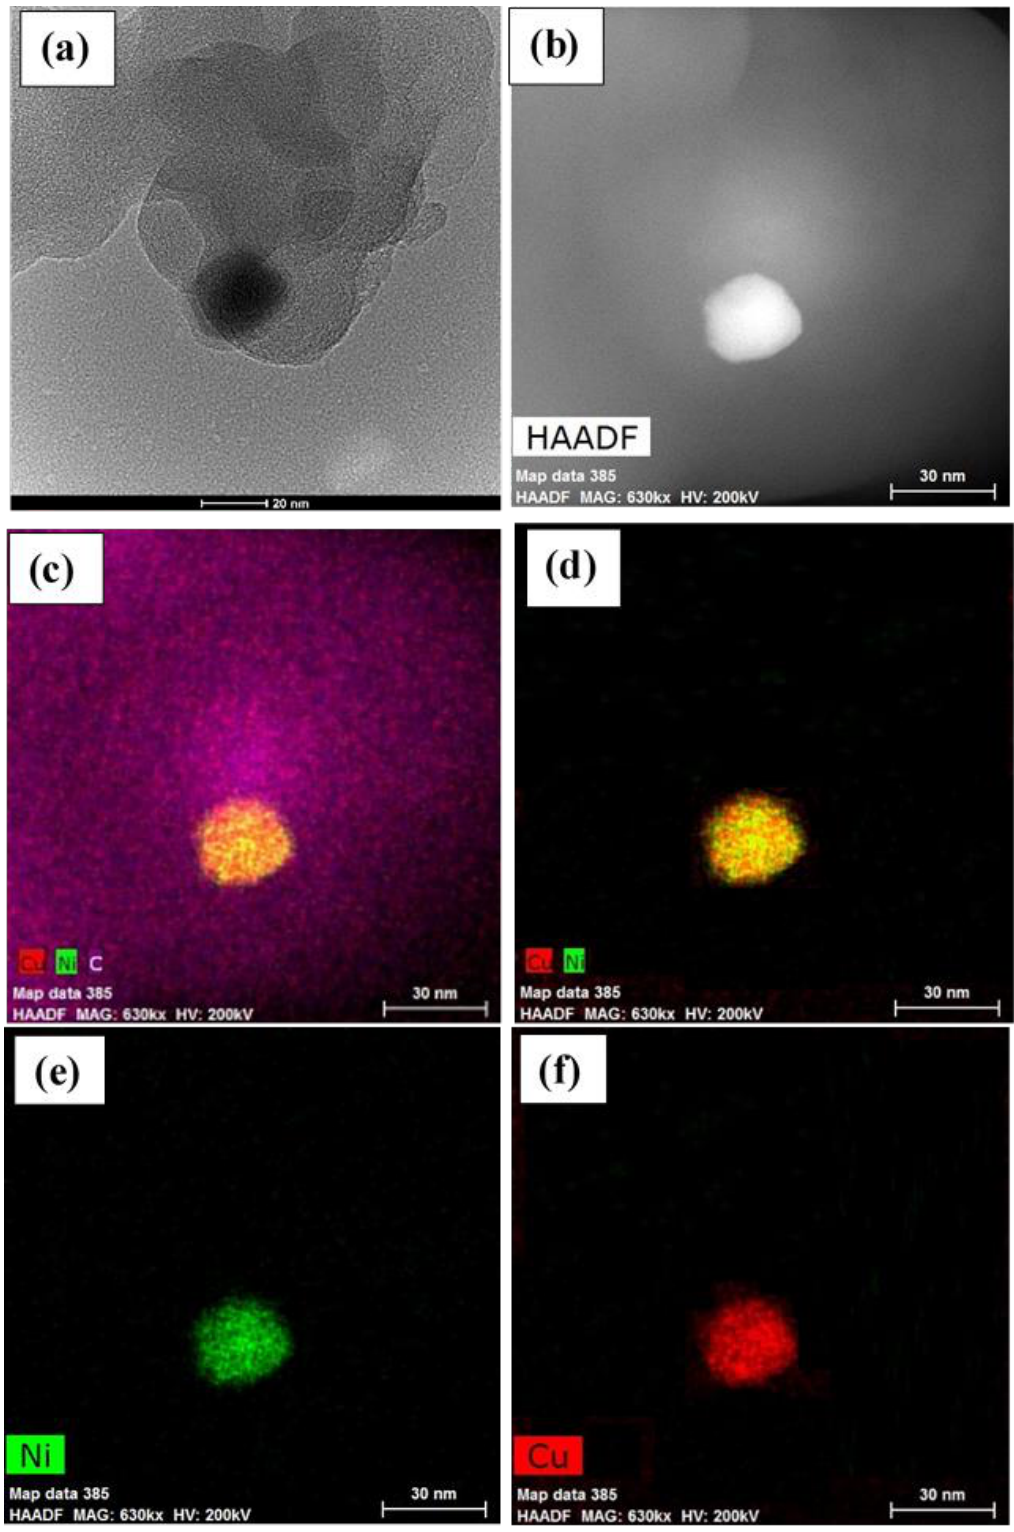
Figure 2. ( a ) TEM BF image of the CuNi-MC and ( b ) High-angle annular dark-field (HAADF)-STEM image, ( c – f ) shows elemental mapping images of bimetallic CuNi nanoparticle-coated mesoporous elemental mapping images of bimetallic CuNi nanoparticle-coated mesoporous carbon.